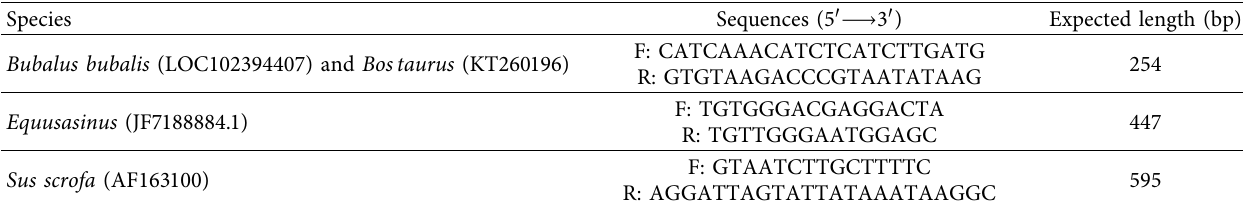
Table 1: Oligonucleotide sequence primers were used in the